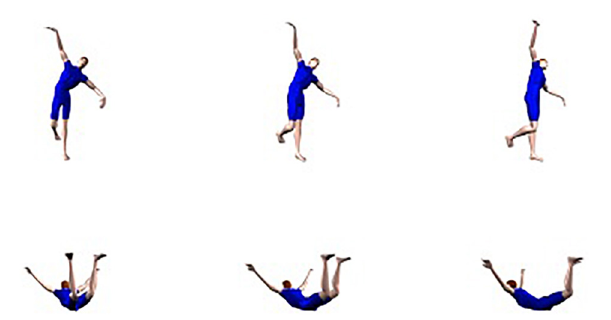
FIGURE 6 | Example of the stimuli used in Experiment 2. The trunk is in a 15 ◦ , 45 ◦ , or 75 ◦ degrees depth orientation (top row) or a 195 ◦ , 225 ◦ , or 275 ◦ depth orientation (bottom